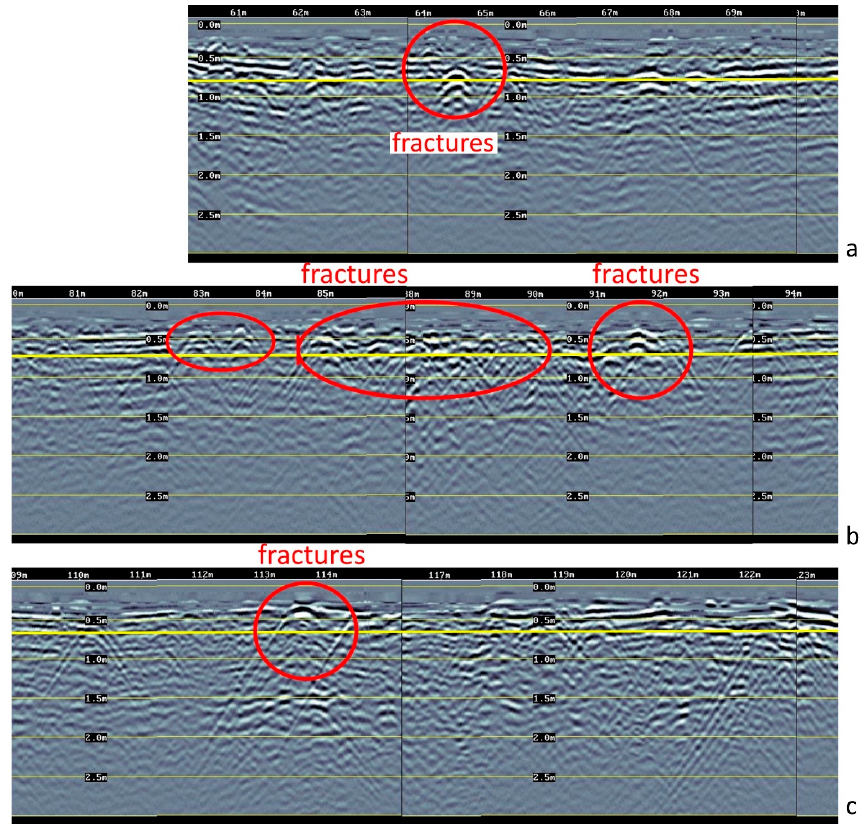
Figure 10. ( a – c ) show in greater detail the most obvious anomalies found close to the visible damaged part of the bridge (Figure 6). The yellow portion clearly shows the thickness of the wings at about 0.6